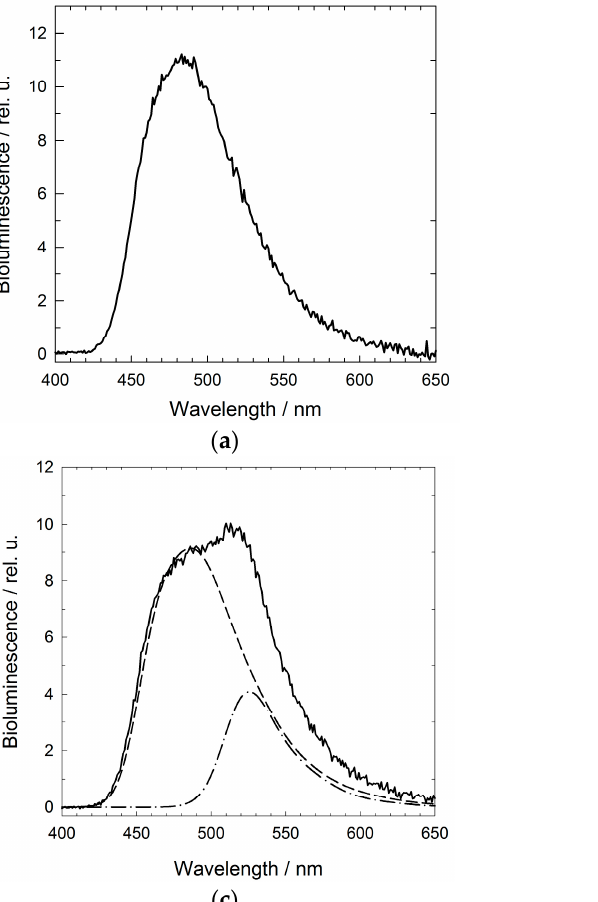
Figure 6. Physicochemical properties of GroEL 14 with incorporated Gaussia princeps luciferase (GroEL 14 -GLuc): ( a ) the bioluminescence spectrum of cells after coexpression of pAC28 groEL-Luc and pET11c groES/EL; nondenaturing PAGE of the cell lysate in the presence of Mg-ADP (Lane 1) and purified GroEL 14 (Lane 2). Protein band visualization by bioluminescence (Lane 1) and Coo- massie staining (Lane 2).